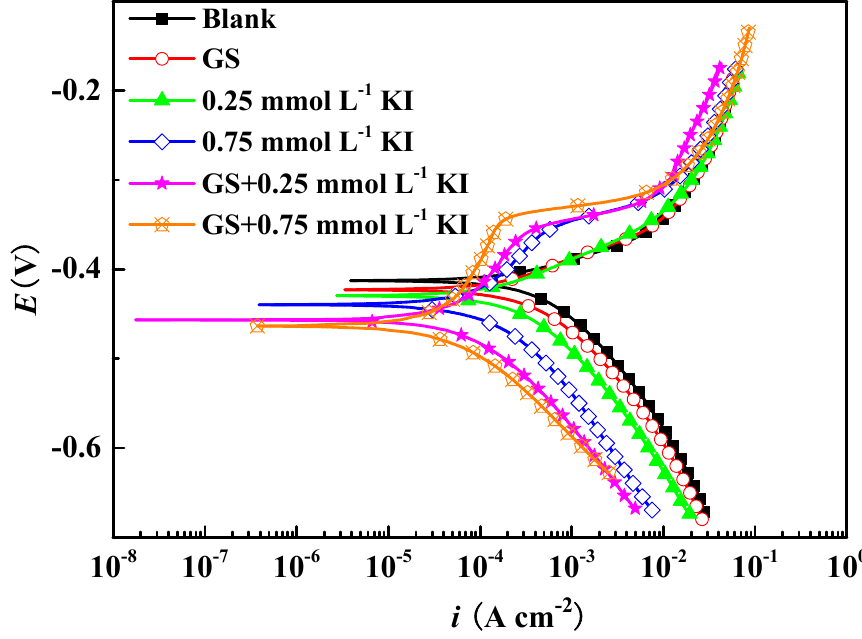
Figure 4. PDP curves of the electrodes in 0.5 mol L − 1 H 2 SO 4 solution without and with different corrosion inhibitor formulations. Table 4. Tafel fitting results of the electrodes in 0.5 mol L − 1 H 2 SO 4 solution without and with differ- ent corrosion inhibitor formulations.